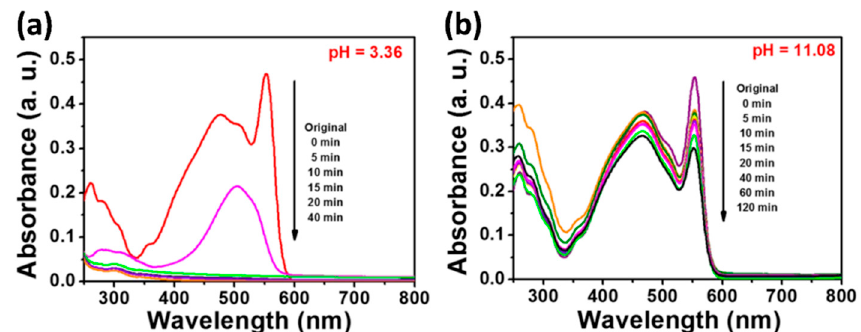
Figure 6. Photodegradation of MO on RhB-sensitized BiOCl hierarchical nanostructures at ( a ) pH = and ( b ) pH = 11.08 (reproduced with permission from [63]. Copyright Royal Society of Chemistry, 3.36 and ( b ) pH = 11.08 (reproduced with permission from [63] . Copyright Royal Society of Chemistry, 2016.).